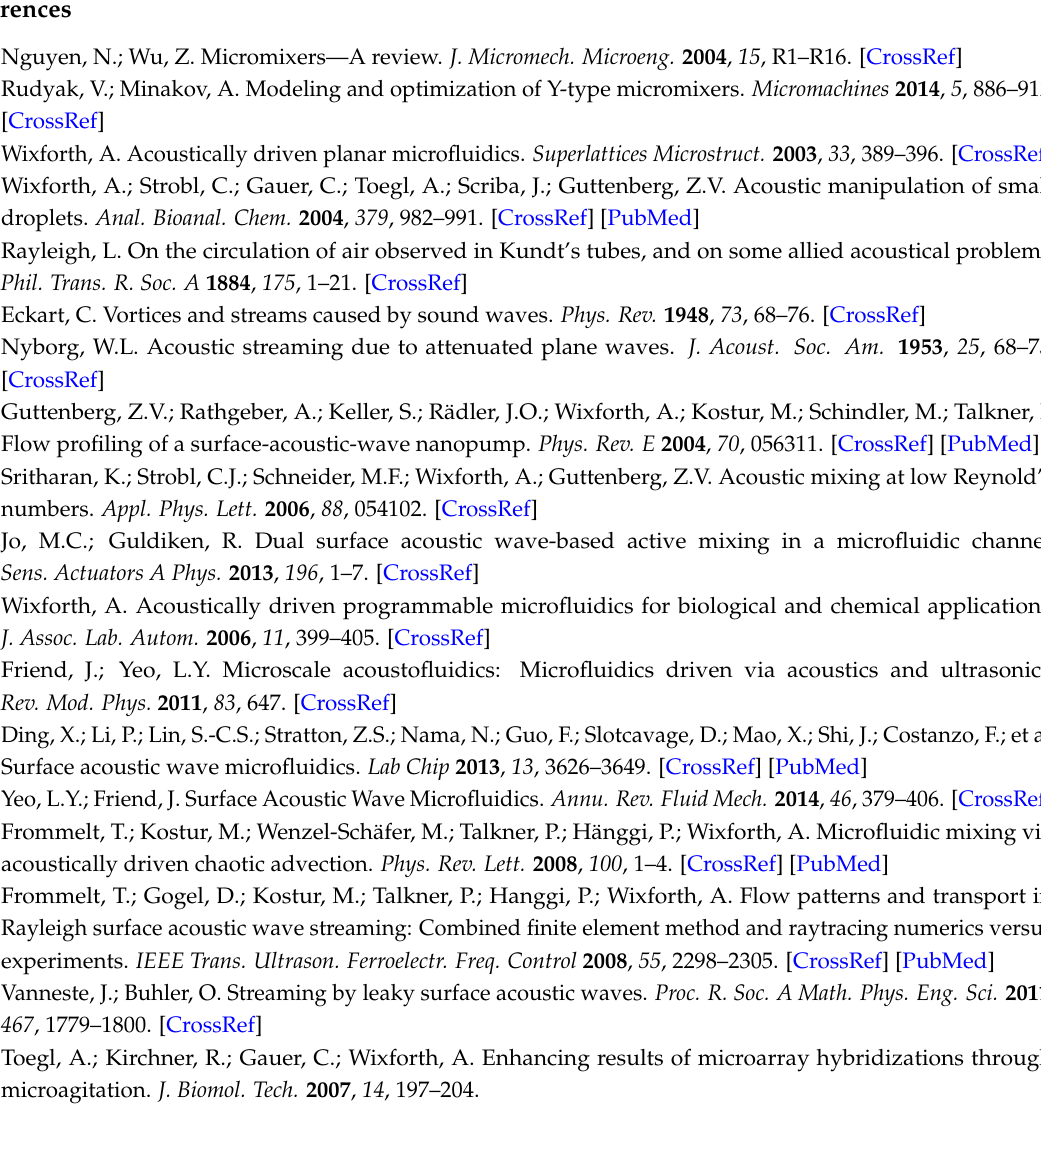
Figure A2. Maximal flow velocity as function of viscosity (data of Figure 4d) in a double logarithmic scale.